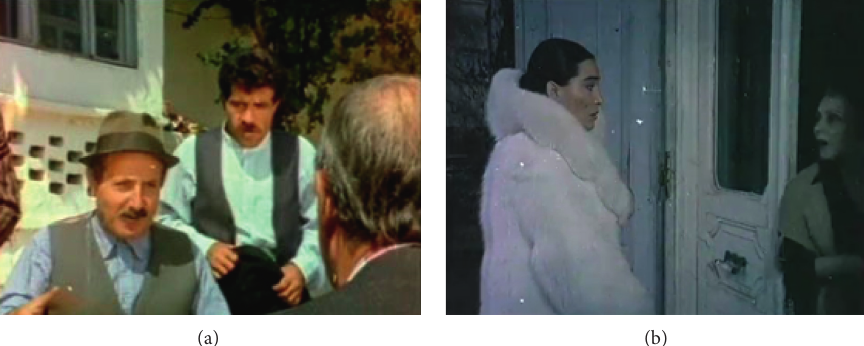
Figure 10: Degraded original datasets used for performance comparison: (a) “yesilcam_1” and (b) “yesilcam_2”.